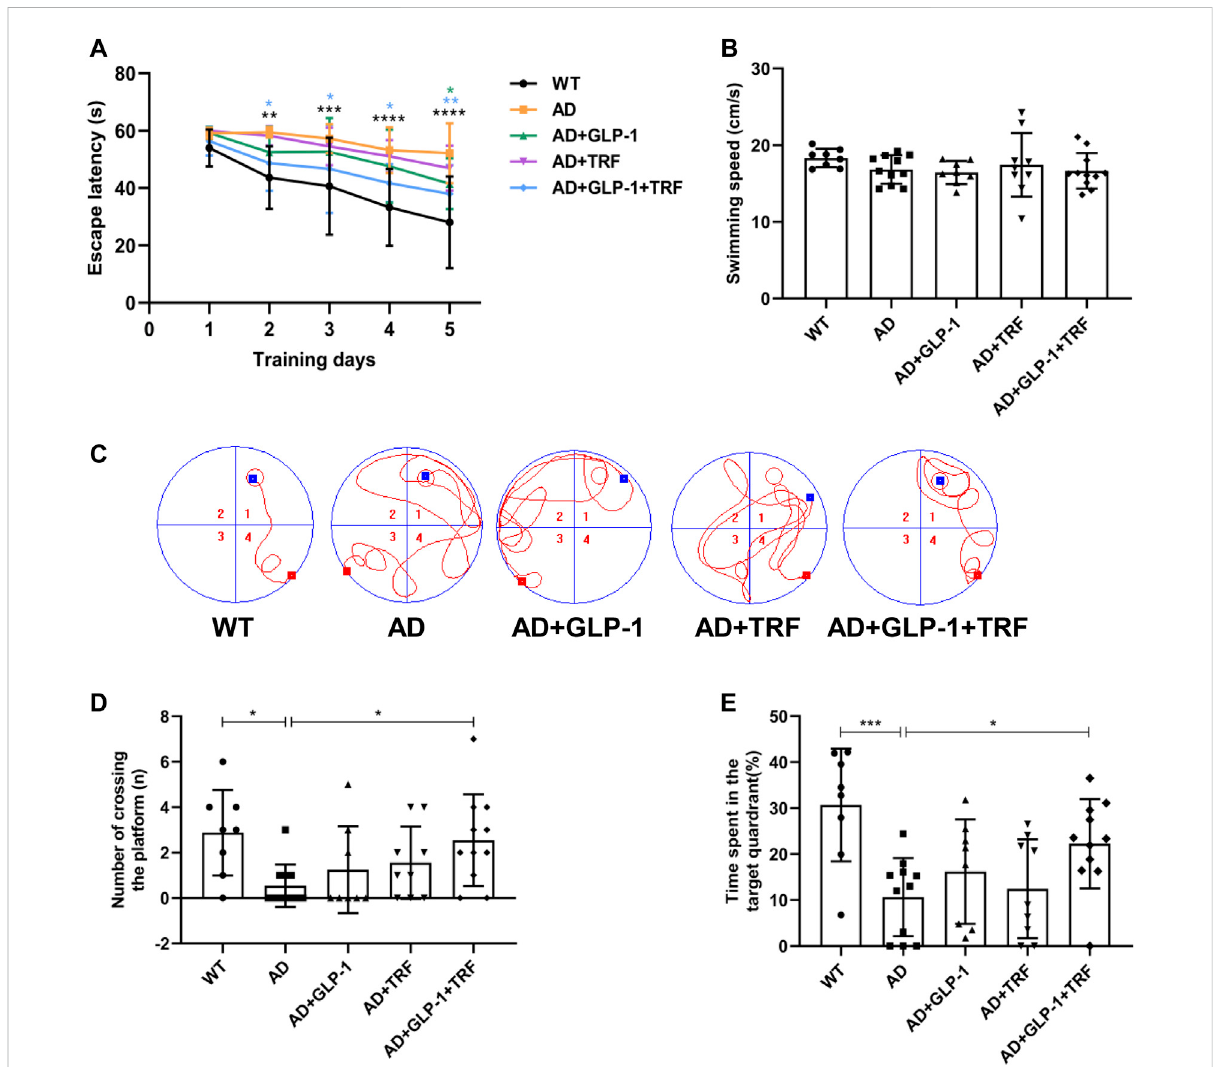
FIGURE 5 Changes in learning and memory capacity under the in fl uence of GLP-1 and TRF. Cognition evaluation of the mice by the MWM. (A) Escape latencyontoahiddenplatformduringthetrainingtrialsoftheMorriswatermazetest.* p < 0.05,** p < 0.01,*** p < 0.001,**** p < 0.0001comparedto the AD group, using One-Way ANOVA followed by Dunnett ’ s test or Dunn ’ s test. (B) Average swimming speed during the training trials. (C) Representativeswimmingtracksofthedifferentgroupsofmiceintheprobetrial. (D) Numbersofcrossingtheplatformduringtheprobetrial.*